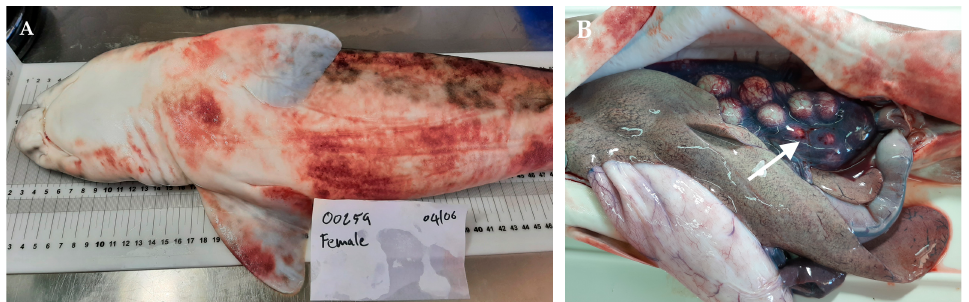
Figure 1. Necropsy and macroscopic lesions detected in S. stellaris affected individuals. ( A ) Petechial lesions and ecchymoses are mainly located on the skin of the belly and pectoral fins. ( B ) Note the intense ovarian congestion (white arrow) in another affected specimen.